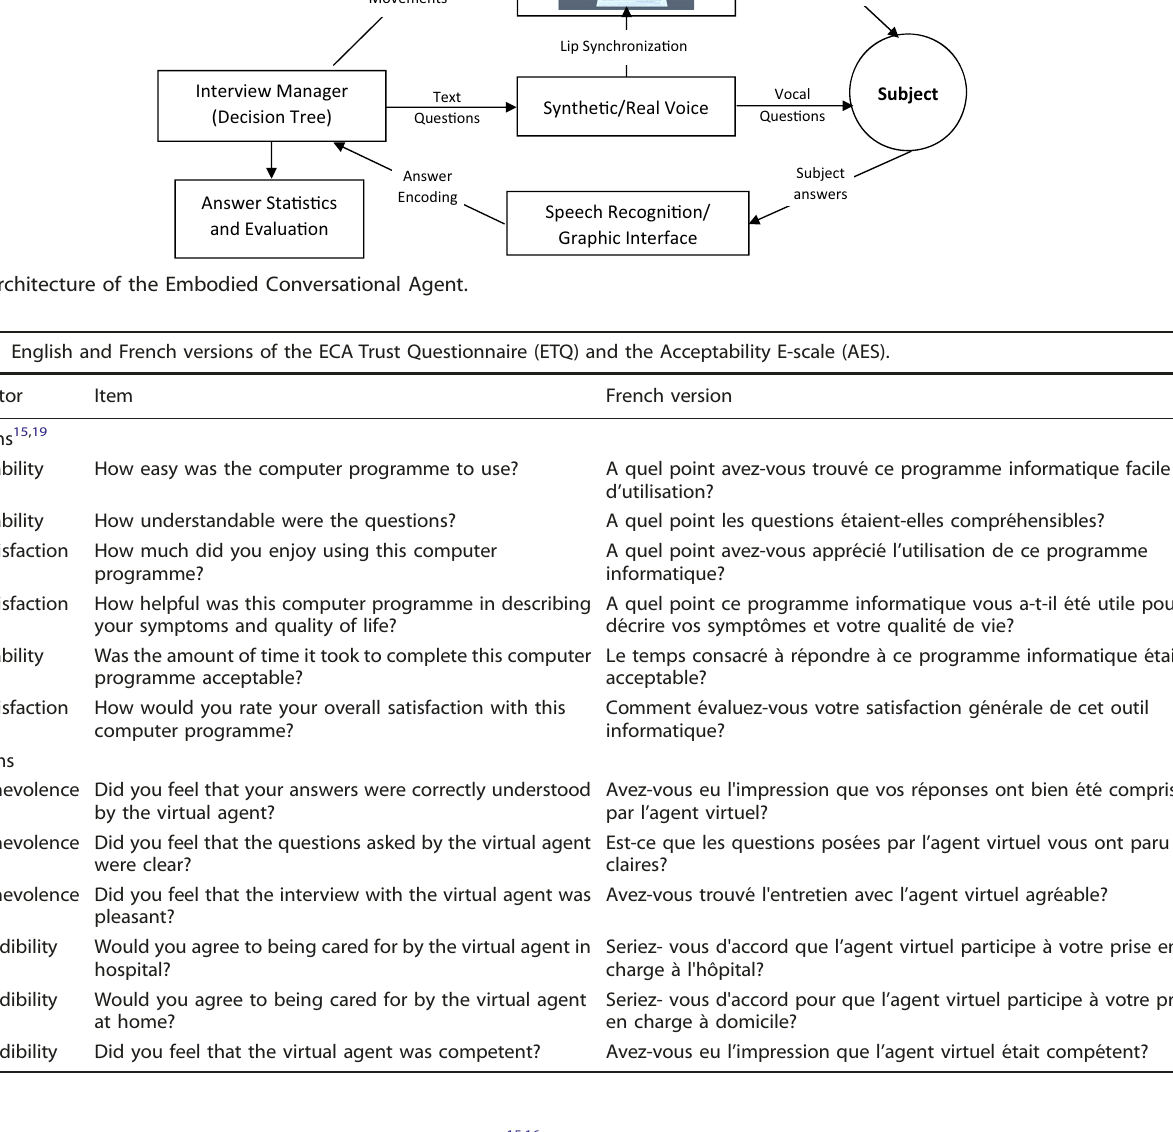
Table 3. To ensure that the ETQ explores factors other than those on the AES scale, we conducted con fi rmatory factor analyses on the six items of the ETQ scale plus the six items of the AES scale with two latent variables underlying the four sub-scores of ETQ and AES. Root Mean Square Error of